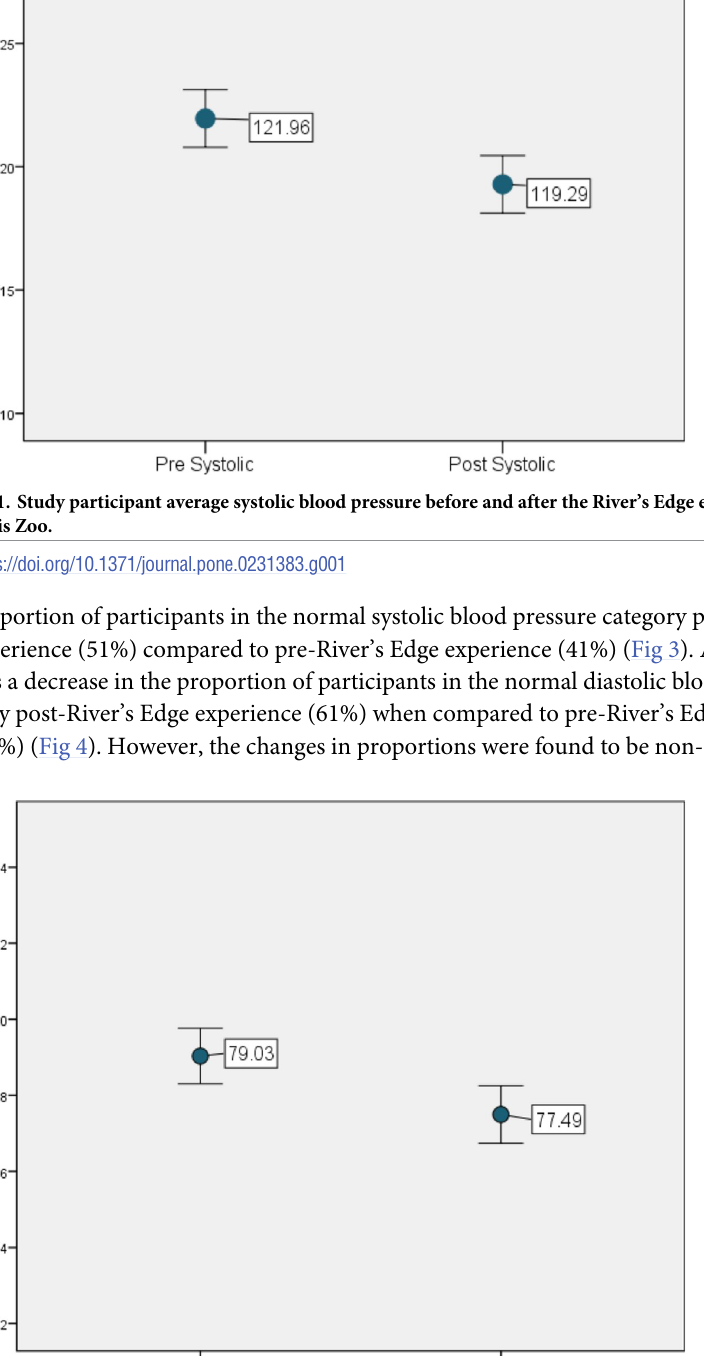
Fig 2. Study participant average diastolic blood pressure before and after the River’s Edge experience at the Saint Louis Zoo.